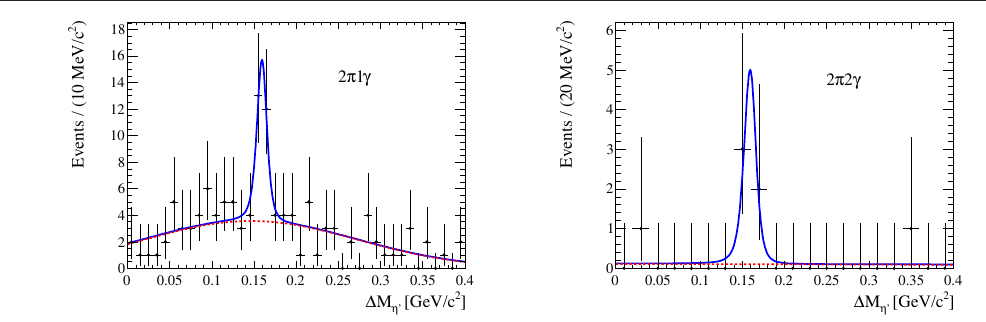
Figure 2. Fit to the ∆ M η (cid:48) distribution for Υ (4 S ) → η (cid:48) Υ (1 S ) candidates reconstructed in the 2 π 1 γ (left) and 2 π 2 γ (right) final states. Data are shown as points, the solid blue line shows the best fit to the data, while the dashed red line shows the background contribution.